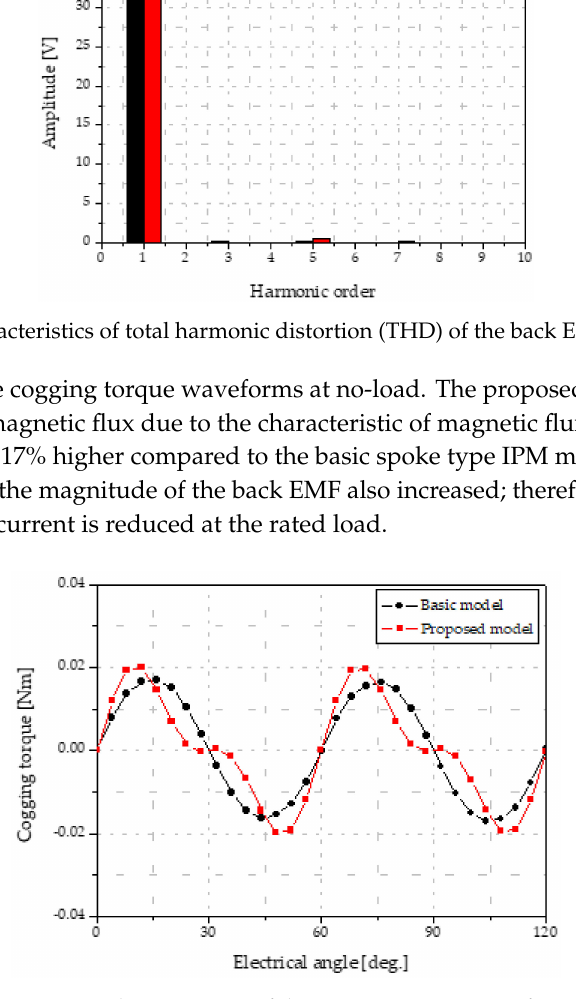
Figure 12. Characteristics of the cogging torque